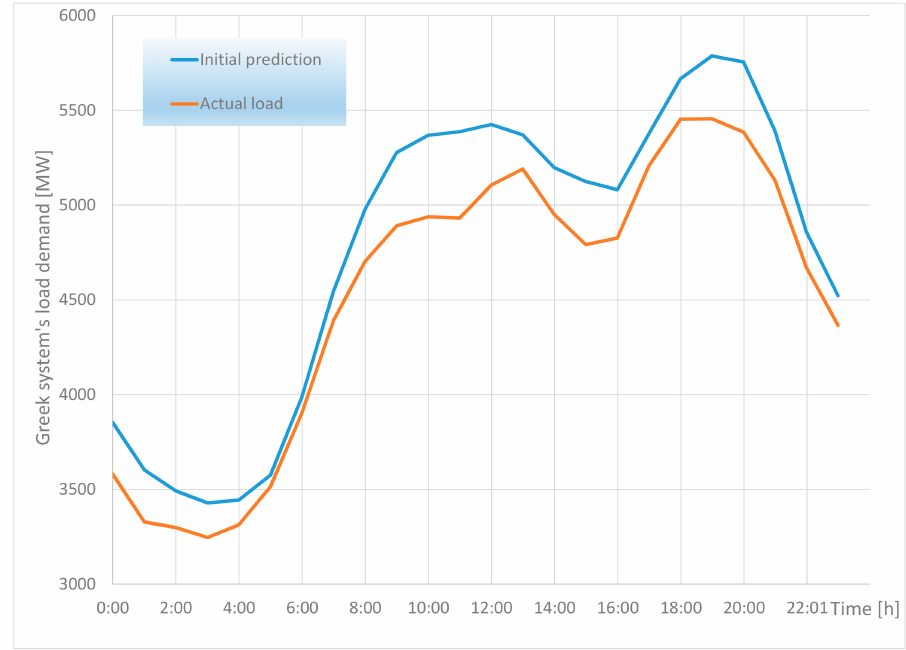
Figure 3. Evolution of the Greek system load on a typical Monday of November, 2022. Predicted versus actual hourly load values